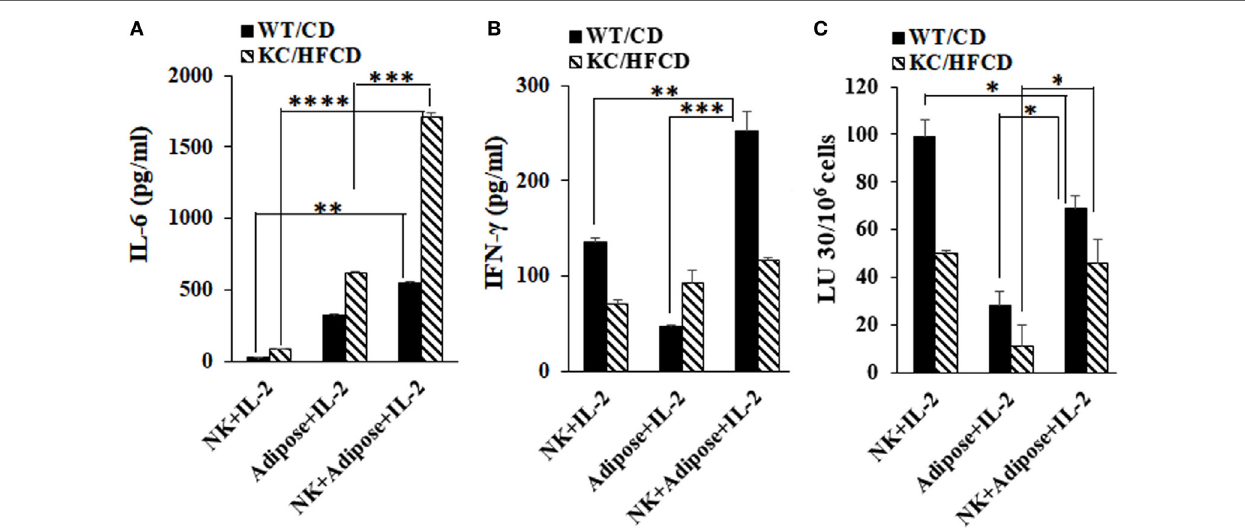
FigUre 3 | Secretion of IL-6 by the peri-pancreatic adipose tissue from obese mice is synergistically increased in the presence of natural killer (NK) cells. Purified NK cells from splenocytes and adipocytes from the peri-pancreatic fat were obtained from WT mice on CD or KC mice on HFCD as described in Section “Materials and Methods.” NK cells treated with IL-2 (10,000 U/ml) in the presence and absence of autologous adipose cells at (NK:adipose cells; 1:1) were cultured and supernatants were harvested after 7 days and the secretion of IL-6 (a) and IFN- γ (B) were determined. One of the three representative experiments is shown in the figures. Cytotoxicity of NK cells cultured as described in (a,B) were assessed against ST63 tumor cells using the standard 4-h 51 Chromium release assay. The LUs 30/106 cells were determined as described in Figure 1B (c) . One of three representative experiments is shown in the